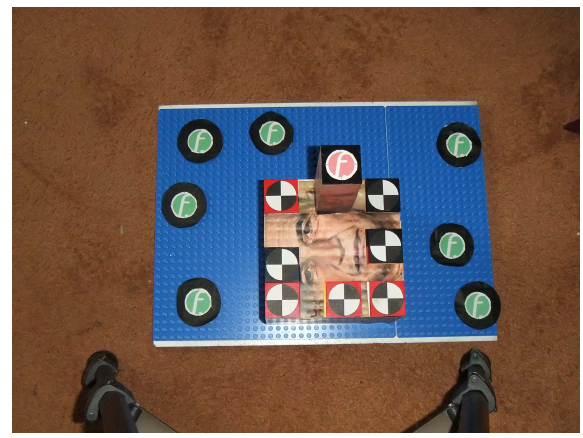
Figure 3: Measurement image of the Lego phantom. +/- 0.55 mm in all coordinate directions. Compared to the “rule of thumb” assessment this result fulfills the expections.